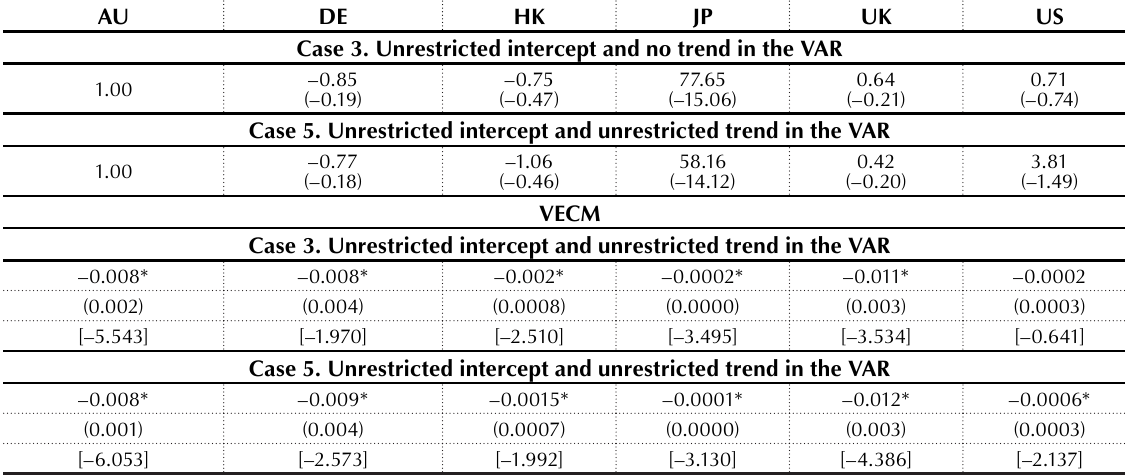
Table 4. Normalized cointegrating vectors AU